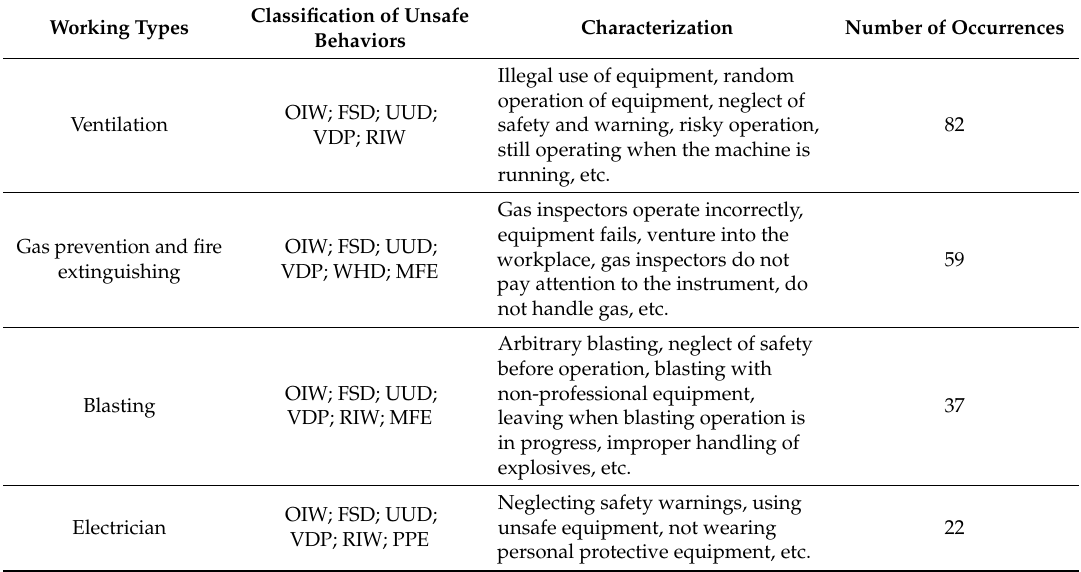
Table 3. Classification of unsafe behaviors of key working types related to gas